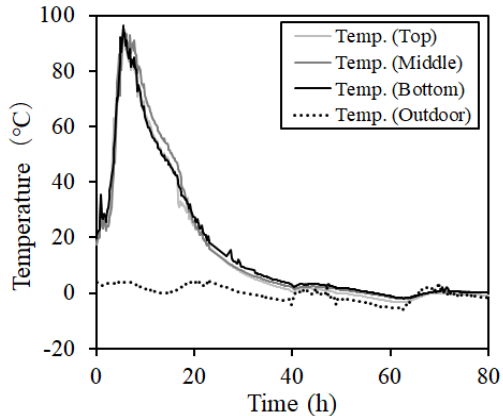
Figure 9. Concrete temperature distribution (steam curing).